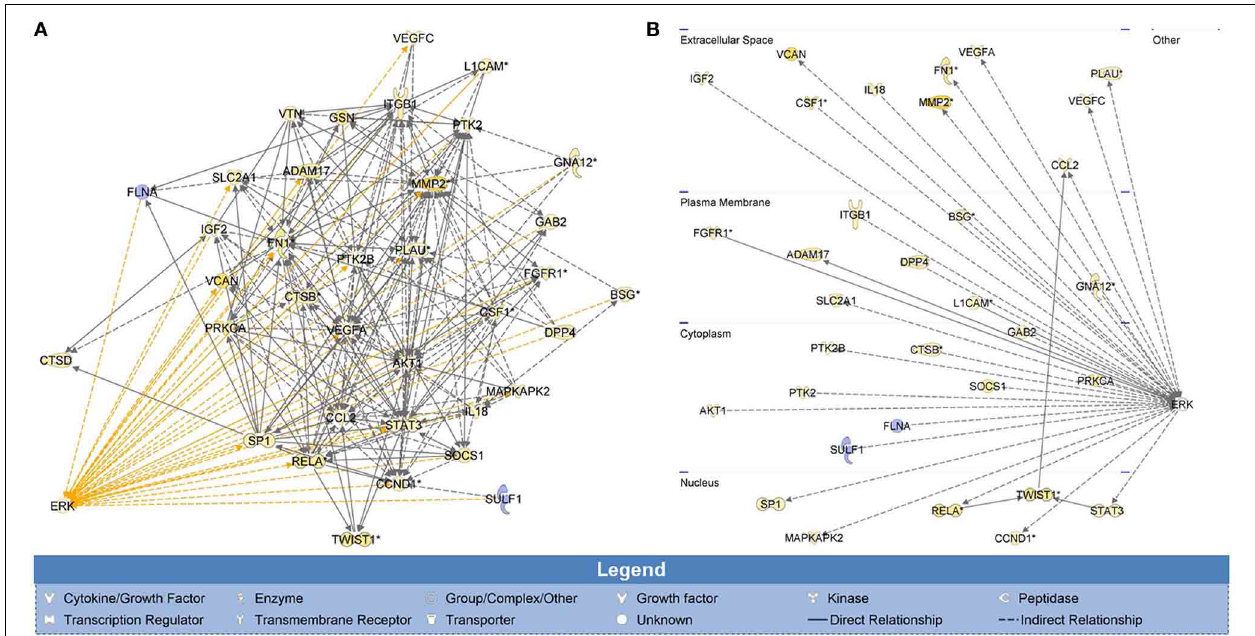
FIGURE 4 | Whole genome analysis of cell invasion network in SWCNT-exposed mesothelial cells. H-Ras-ERK invasion signaling network was created from whole genome expression data previously deposited on NCBI’s Gene Expression Omnibus (GenBank ID: GSE48855) using IPA. Gene signaling networks (GSN) associated with cell invasion were created and mapped. Genes were included in the GSN if they promoted invasion and were overexpressed or if they